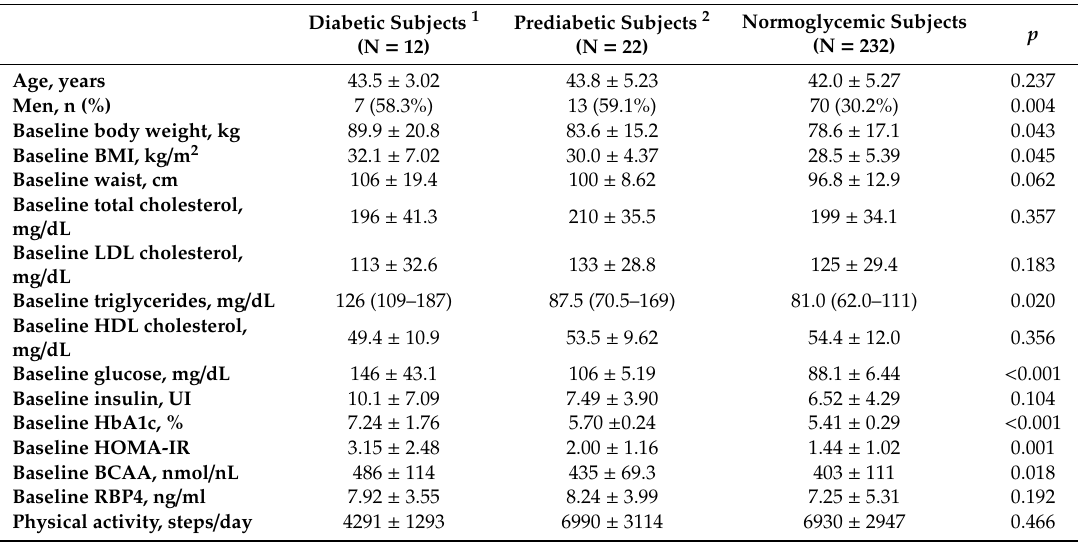
Table 2. Baseline biochemical and anthropometric characteristics and baseline BCAAs and RBP4 concentrations according to impaired glycemic